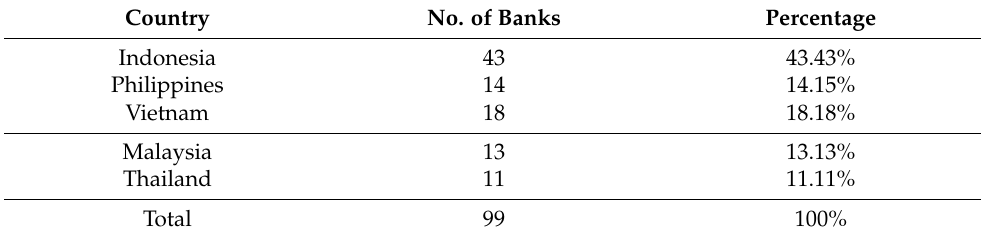
Table 4. The distribution of listed banks by country.